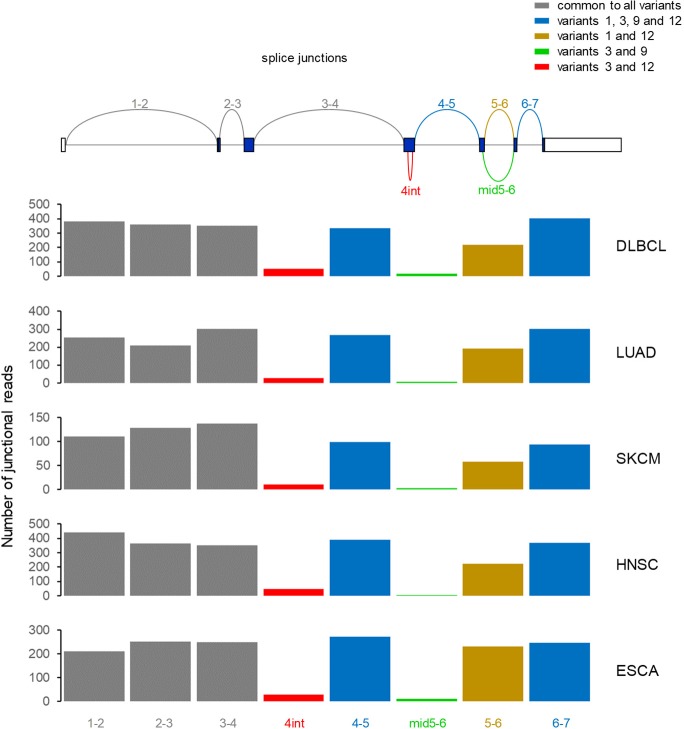
Splice junction analysis of CD274 variant expression.Annotated splice junctions in the CD274 gene (top) were numbered according to the linked exons (e.g. 1–2); 4int refers to splicing internal to exon 4, specific to variants 3 and 12; mid5-6 refers to splicing with donor internal to exon five and acceptor at the start of exon 6, specific to variants 3 and 9. Plotted are the numbers of junctional reads corresponding to the annotated splice junctions in aggregate bam files from the indicated TCGA cancer types.